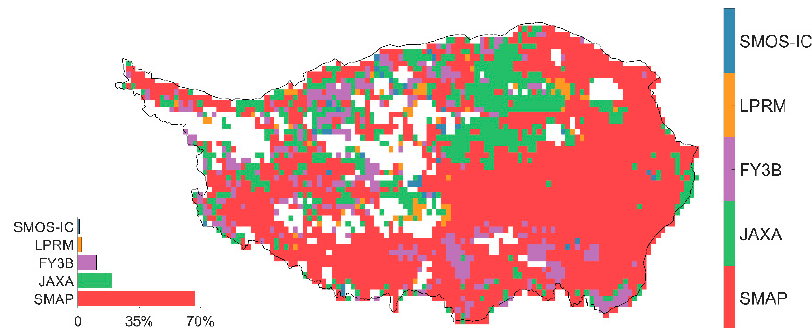
Figure 5. Spatial distribution of the SM products with the minimum uncertainty among the five SM products.